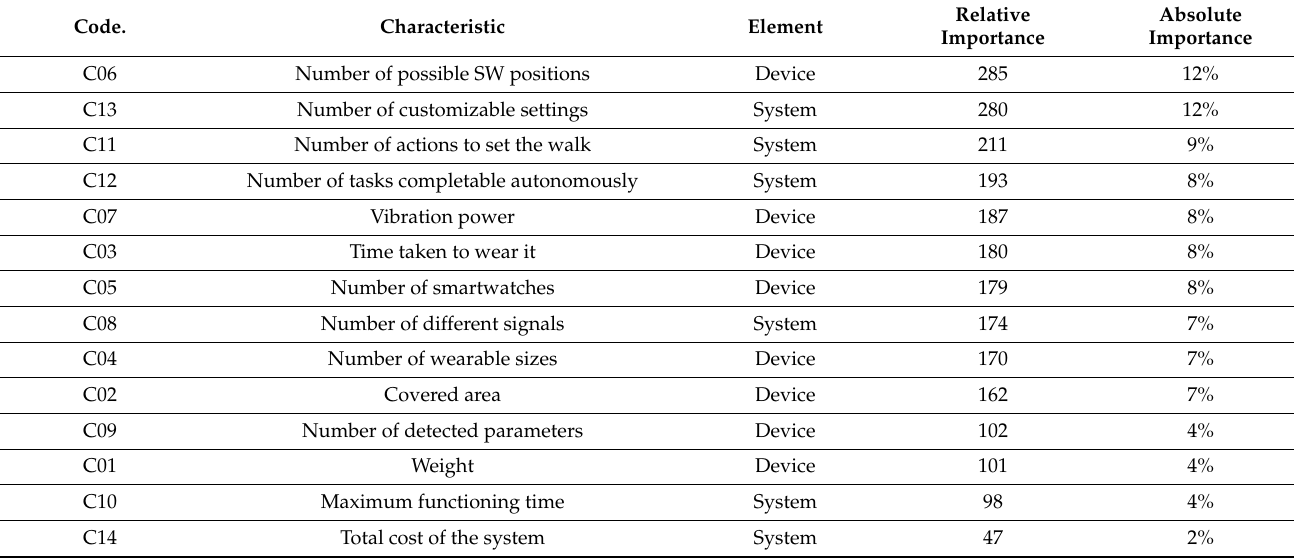
Table 2. Final list of characteristics’ relative and absolute